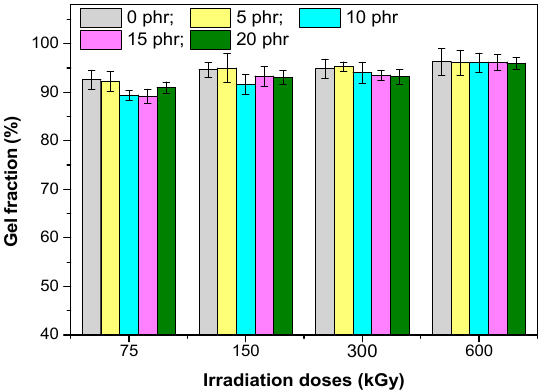
Figure 7. Gel fraction versus electron beam irradiation dose and the amount of hemp fibers.